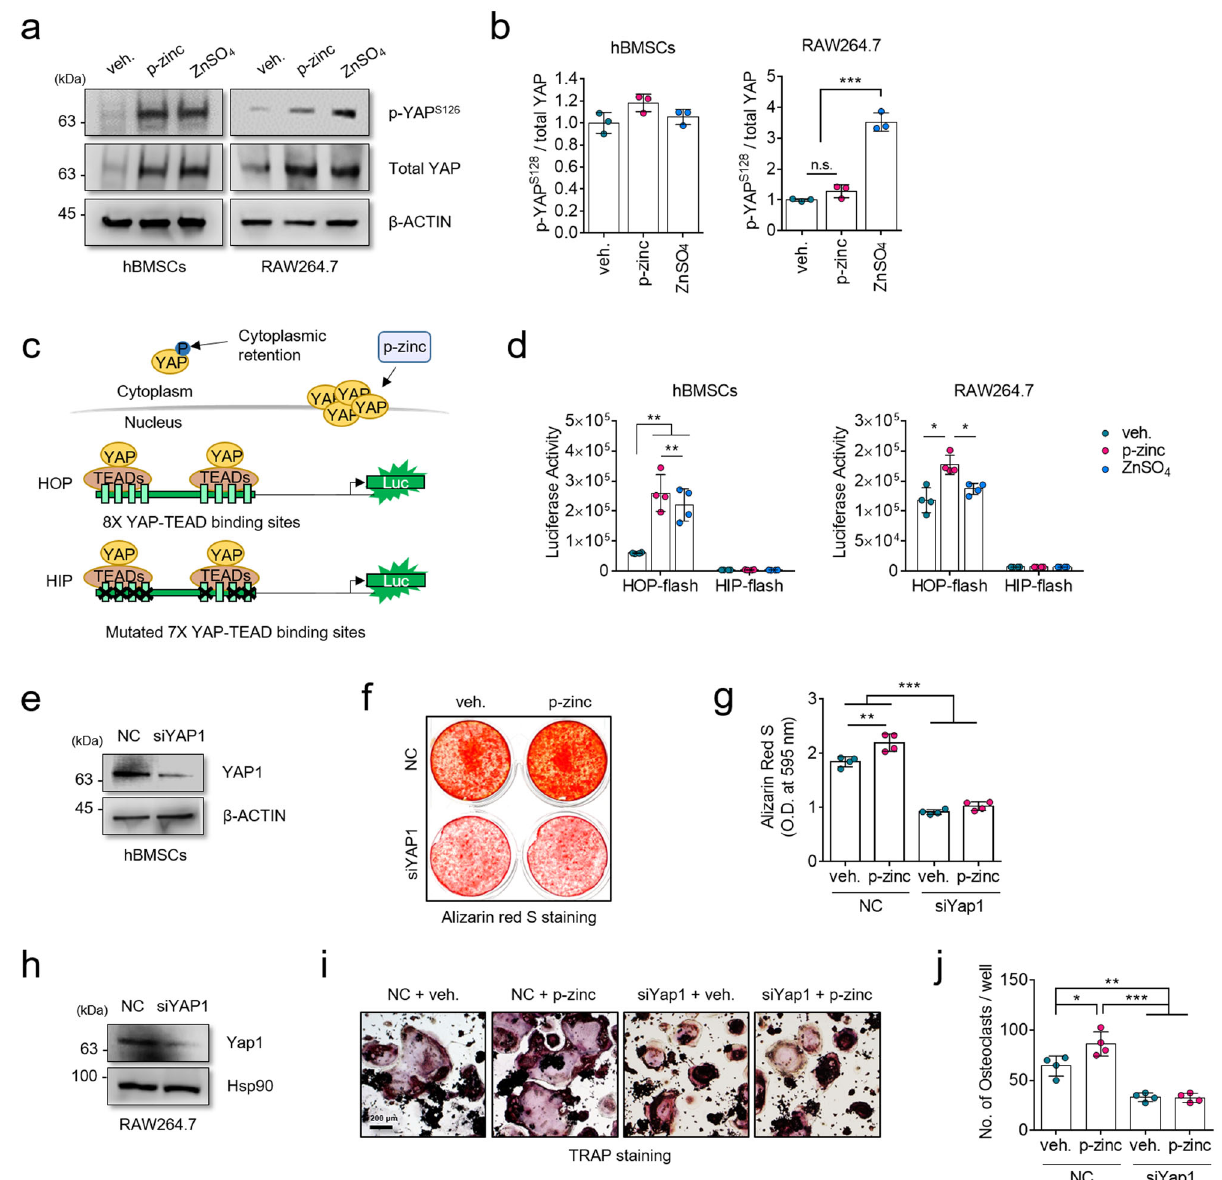
Fig. 4 Knockdown study of YAP in polaprezinc-treated hBMSCs and RAW264.7 cells. a Protein levels of YAP and phosphorylated YAP S126 were analyzed in hBMSCs and RAW264.7 cells using western blotting for cells treated with vehicle, polaprezinc (50 μ M), or zinc sulfate (50 μ M). b The band intensity was quanti fi ed using ImageJ software ( n = 3, in triplicate) and the protein level of phosphorylated YAP S126 was normalized to total YAP protein level. *** P < 0.001 compared with vehicle-treated cells. c Schematic of the HOP/HIP- fl ash reporter assay. The HOP luciferase vector has eight YAP-TEAD binding sites whereas seven YAP-TEAD binding sites are mutated in the HIP vector. The quantitative increase of YAP protein by polaprezinc is expected to increase the transcriptional activity of YAP protein. d YAP-TEAD transcriptional activity was assessed by luciferase reporter constructs in hBMSCs or RAW264.7. * P < 0.05; ** P < 0.01. e Western blot analysis of YAP1 protein levels upon transfection with or without YAP1 siRNA in hBMSCs. f Alizarin red S staining was performed to detect mineral deposition on day 14 in negative control or human YAP-targeting siRNA-transfected hBMSCs treated with vehicle or polaprezinc (50 μ M). g For quantitative analysis of alizarin red S staining, absorbance was measured at 595 nm following destaining with 10% cetylpyridinium for 30 min. h Western blot analysis of Yap1 protein level transfected with or without Yap1 siRNA in RAW264.7. i Negative control or mouse YAP-targeting siRNA-transfected RAW264.7 cells treated with vehicle or polaprezinc (50 μ M) were seeded into 24-well culture plates and treated for 5 days with RANKL (50 ng/mL). TRAP staining was performed to visualize TRAP-positive cells. Scale bar = 200 μ m. j The number of TRAP-positive multinucleated osteoclasts (5 ≥ nuclei) was